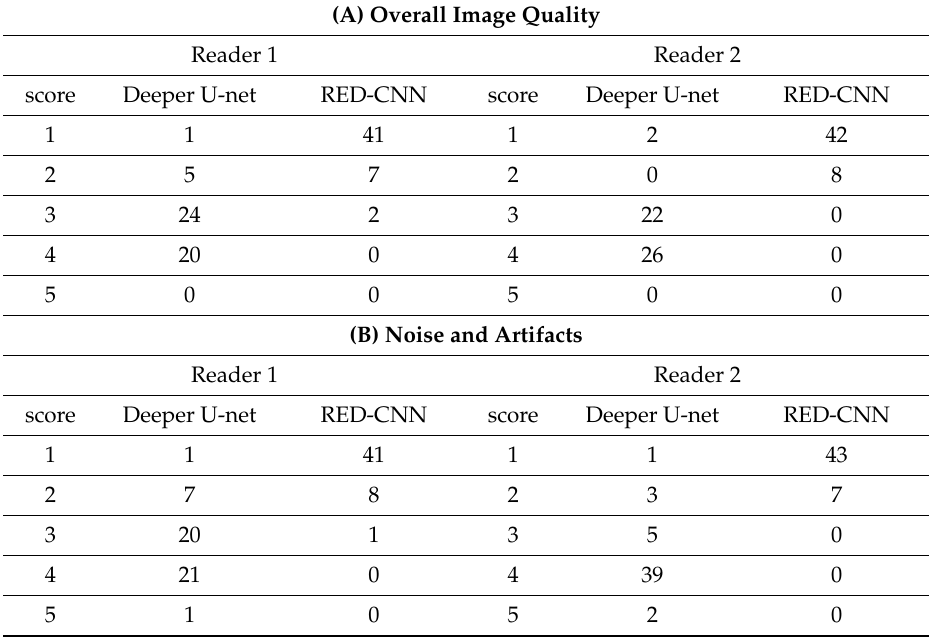
Figure 4. Visual evaluation of entire CT image quality by the two readers using different deep learning algorithms.